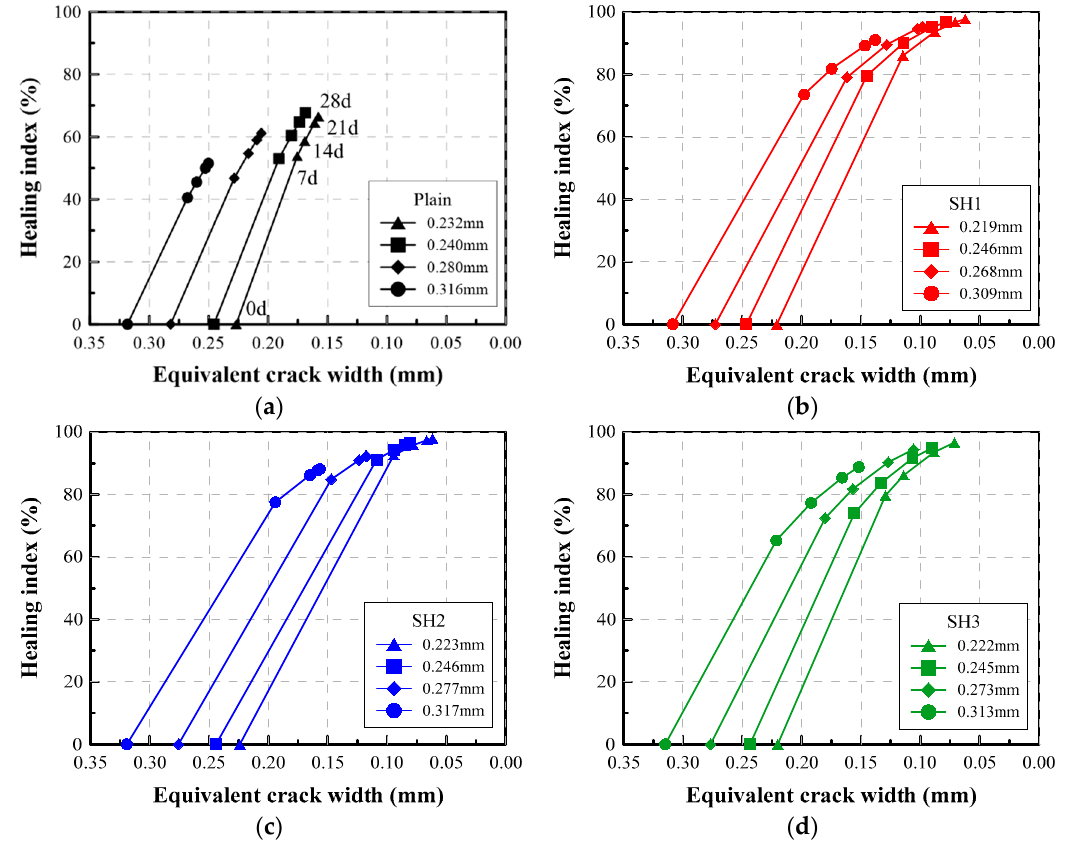
Figure 12. Variation of the crack width and the healing index for each mixture: ( a ) Plain, ( b ) SH1, ( c ) SH2, ( d ) SH3. For example, an initial crack of 0.219 mm made on an SH1 specimen could be reduced to 0.115, 0.088, 0.071, and 0.062 mm after 7, 14, 21, and 28 days of the healing period, respectively. Accordingly, the healing index increases to 86, 94, 97, and 99%, respectively.